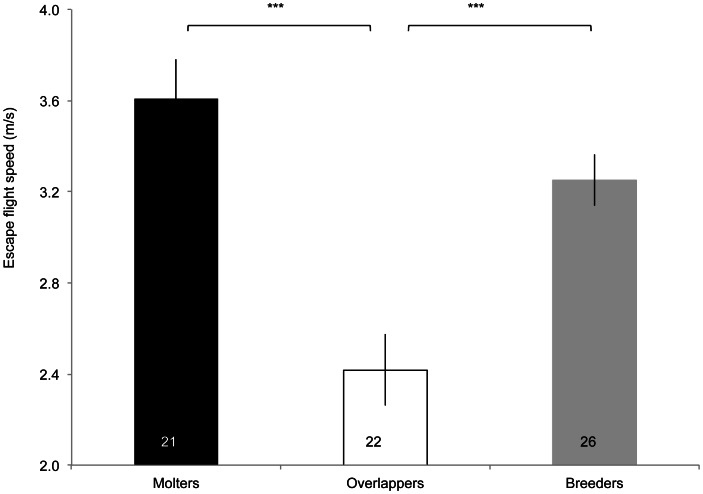
Escape flight speed (m/s, mean ± SE) according to state (***p<0.0001).Numbers inside bars indicate sample sizes.